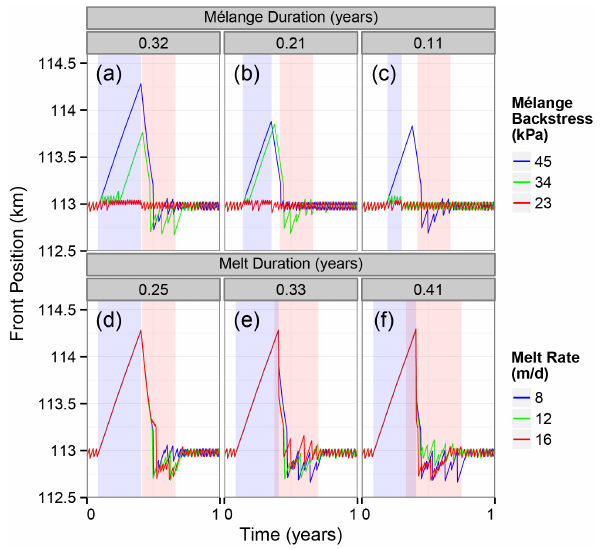
Figure 9. Plots showing terminus position through 1 year for vary- | ing mélange season duration (a – c) and melt season duration (d – f) . 36 Durations of mélange and melt season are indicated by blue and red shading, respectively. Line colour indicates varying magnitude of melt rate and mélange backstress. The blue line in panels (a) and (d) represent the baseline model from experiment 1 (Fig. 6). Changing panels and line colours indicate perturbations under progressively warmer climate